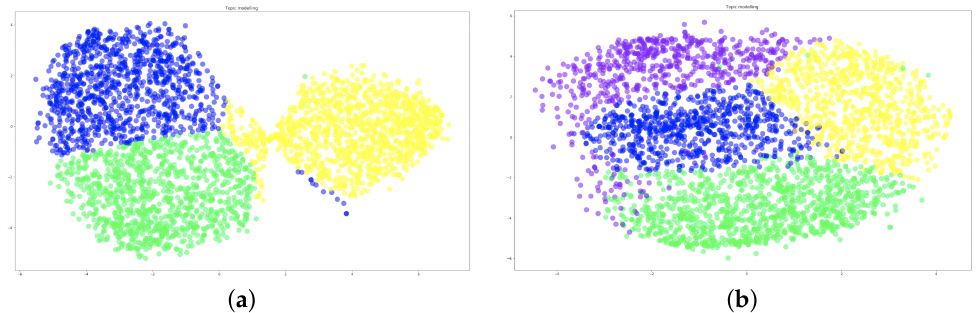
Figure 5. Boolean-IDF and LogTF-IDF weighting schemas’ results for the Luggage dataset. ( a ) Dataset D9. t-SNE representation. B-IDF weighting schema K = 3. ( b ) Dataset D9. t-SNE representation. LogTF-IDF weighting schema K = 4.